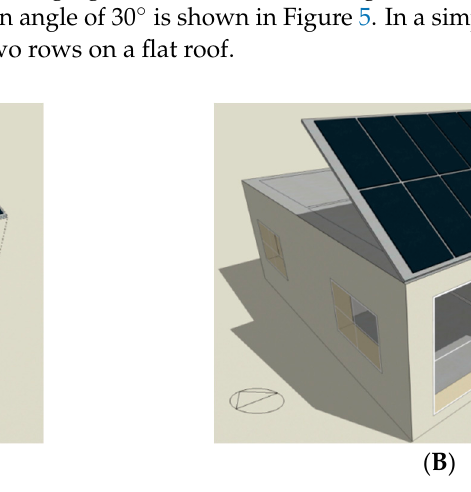
Figure 4. The solar domestic hot water system composed of solar thermal collectors, pumps, a water storage tank and a water heater.